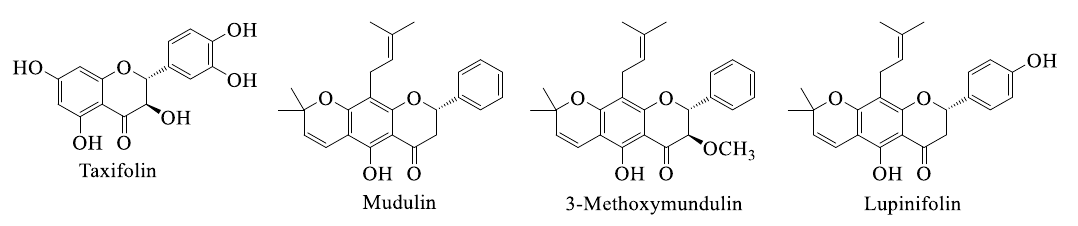
Figure 2. Structure of some flavonoid derivatives found in G. tridentata .